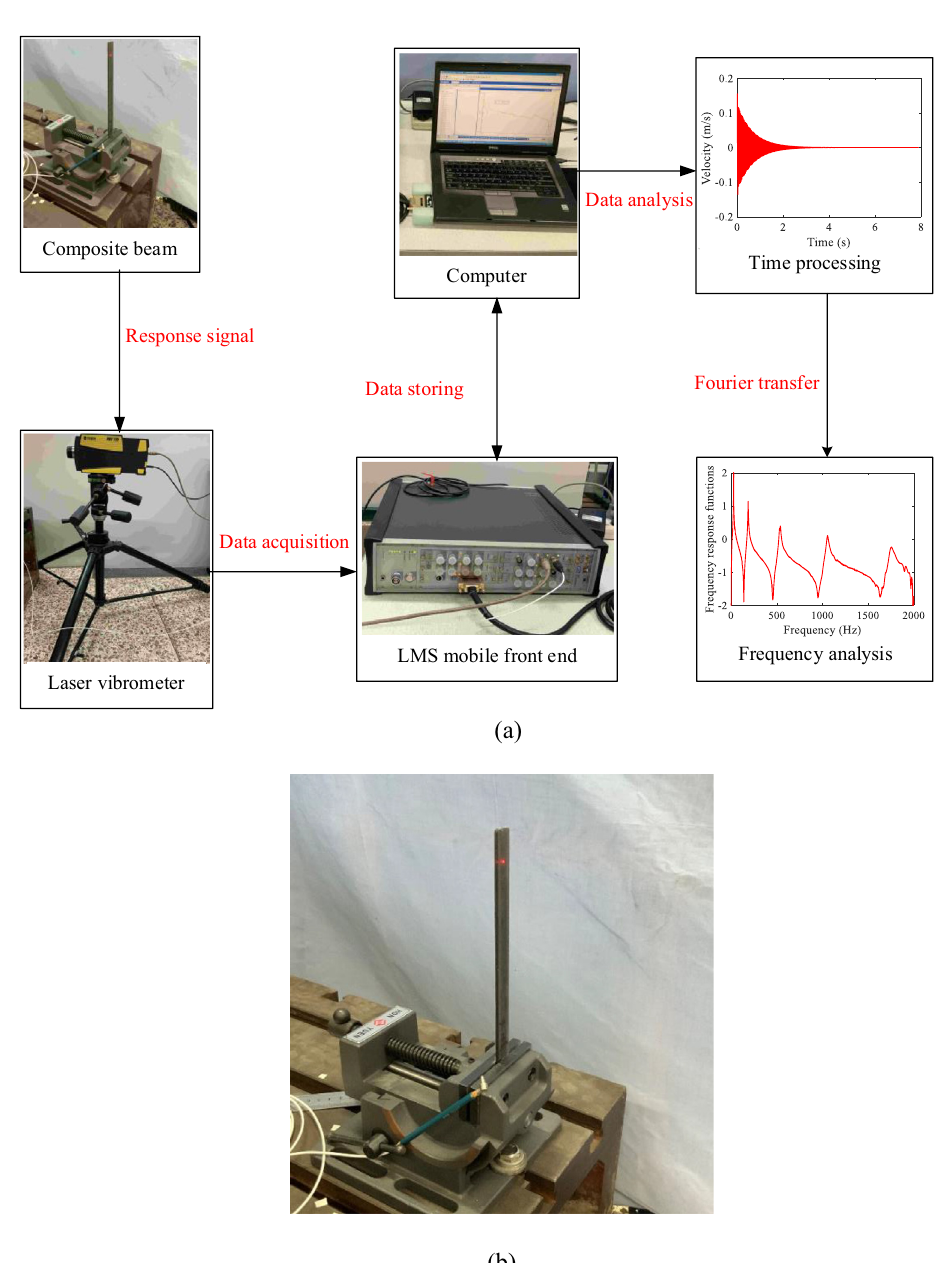
Figure 4: Vibration test setup: ( a ) schematic diagram of measuring system; ( b ) enlarged picture of cantilever beam